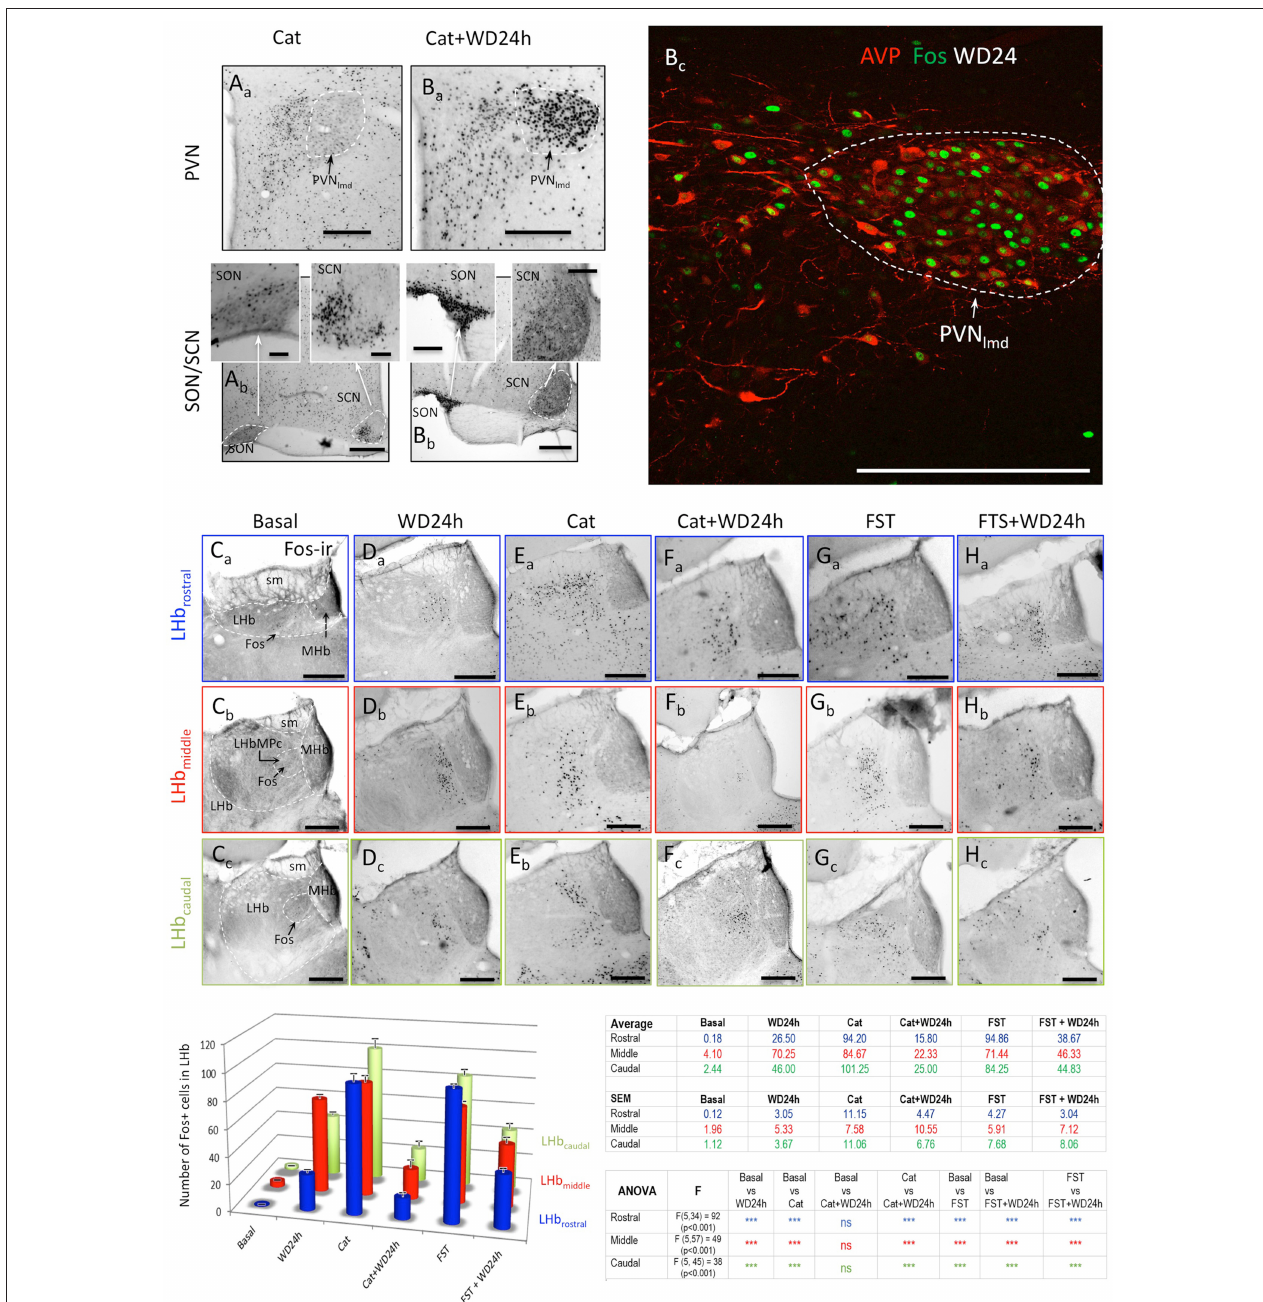
FIGURE 8 | Differential neuronal activation of lateral habenula by cat exposure or forced swimming test (FST) in rats with or without 24h of water deprivation (WD24) suggested AVP-glutamate pathway activates habenular internal inhibitory mechanisms. Representative photomicrographs of Fos expression patterns: panels (A) and (B) show the Fos expression patterns in the hypothalamic AVP containing paraventricular (PVN), supraoptic (SON) and suprachiasmatic (SCN) nuclei, as a consequence of either cat exposure alone (A a ,A b ) or cat exposure + WD24 (B a ,B b ) . Panel B c shows the Fos expression in PVN after WD24. PVNlmd: lateral magnocellular division of PVN; PVNmpd: medial parvocellular division of PVN; (C a-c –H a-c ) : representative photomicrographs of Fos expression corresponding to each group at each habenular rostro-caudal levels (lettered and framed with the same color code of the histogram). Color-coded histograms and statistical table show Fos+ nuclear counting in whole habenular sections, sampled at three rostro-caudal levels, namely, the rostral (blue), the middle (mid, red) and the caudal (green) of 6 experimental groups: basal ( n = 4 ), WD24 ( n = 4 ), cat exposure ( n = 8 ), cat exposure + WD24 ( n = 8 ), FST ( n = 5 ), FST + WD24 ( n = 7 ). Quantitative results and significance levels are provided in the adjacent table. Scale bars: 100 µ m.